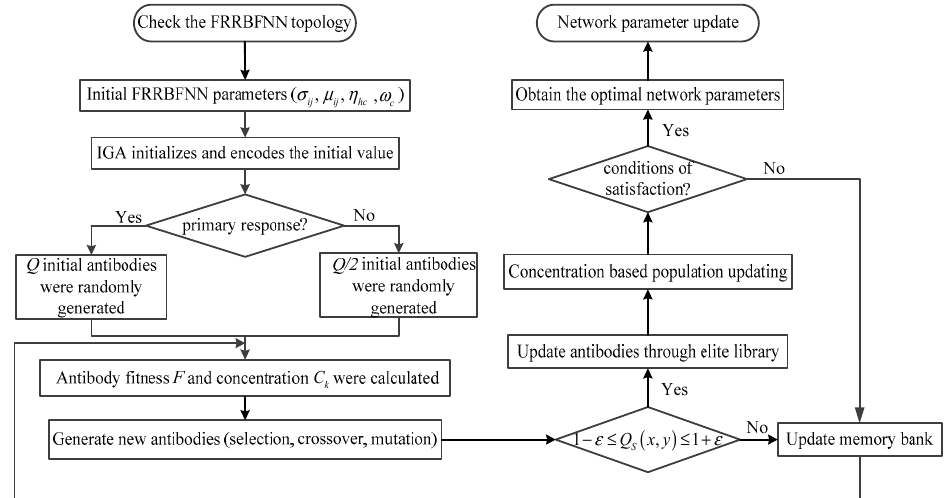
Figure 4. Flow of FRRBFNN parameter optimization algorithm based on AIGA.